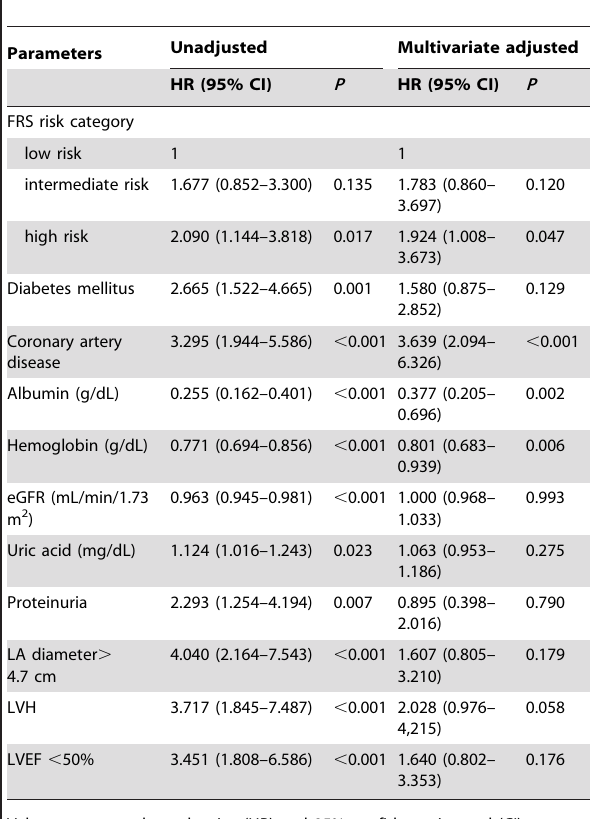
Table 2. Relation of FRS category to cardiovascular events using Cox proportional hazards